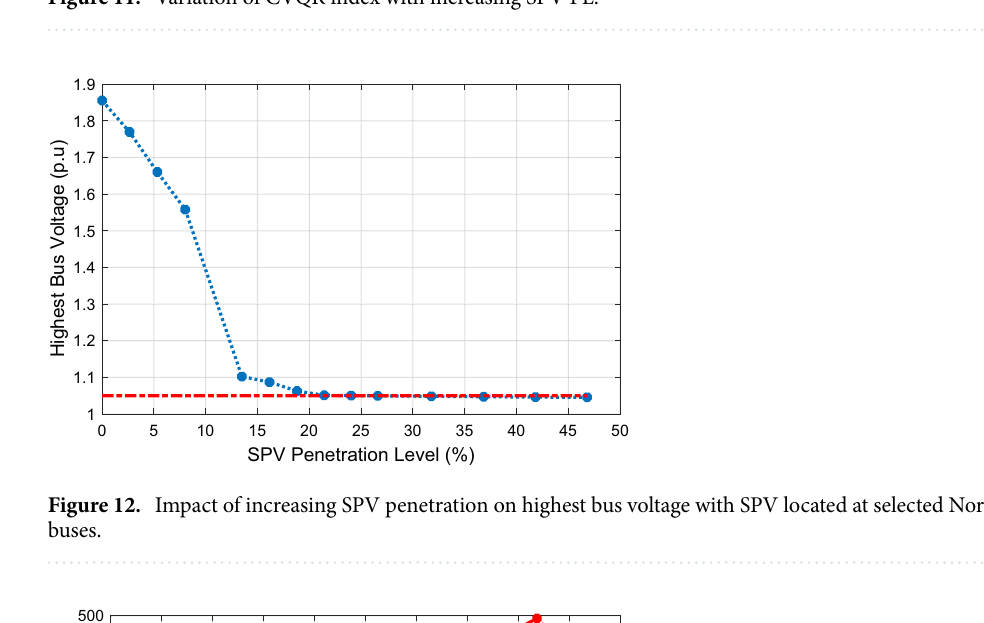
Figure 11. Variation of CVQR index with increasing SPV PL.